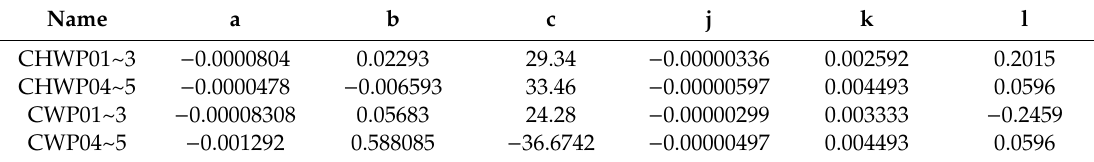
Table 3. Chiller model parameters. Table 4. Pump model parameters.